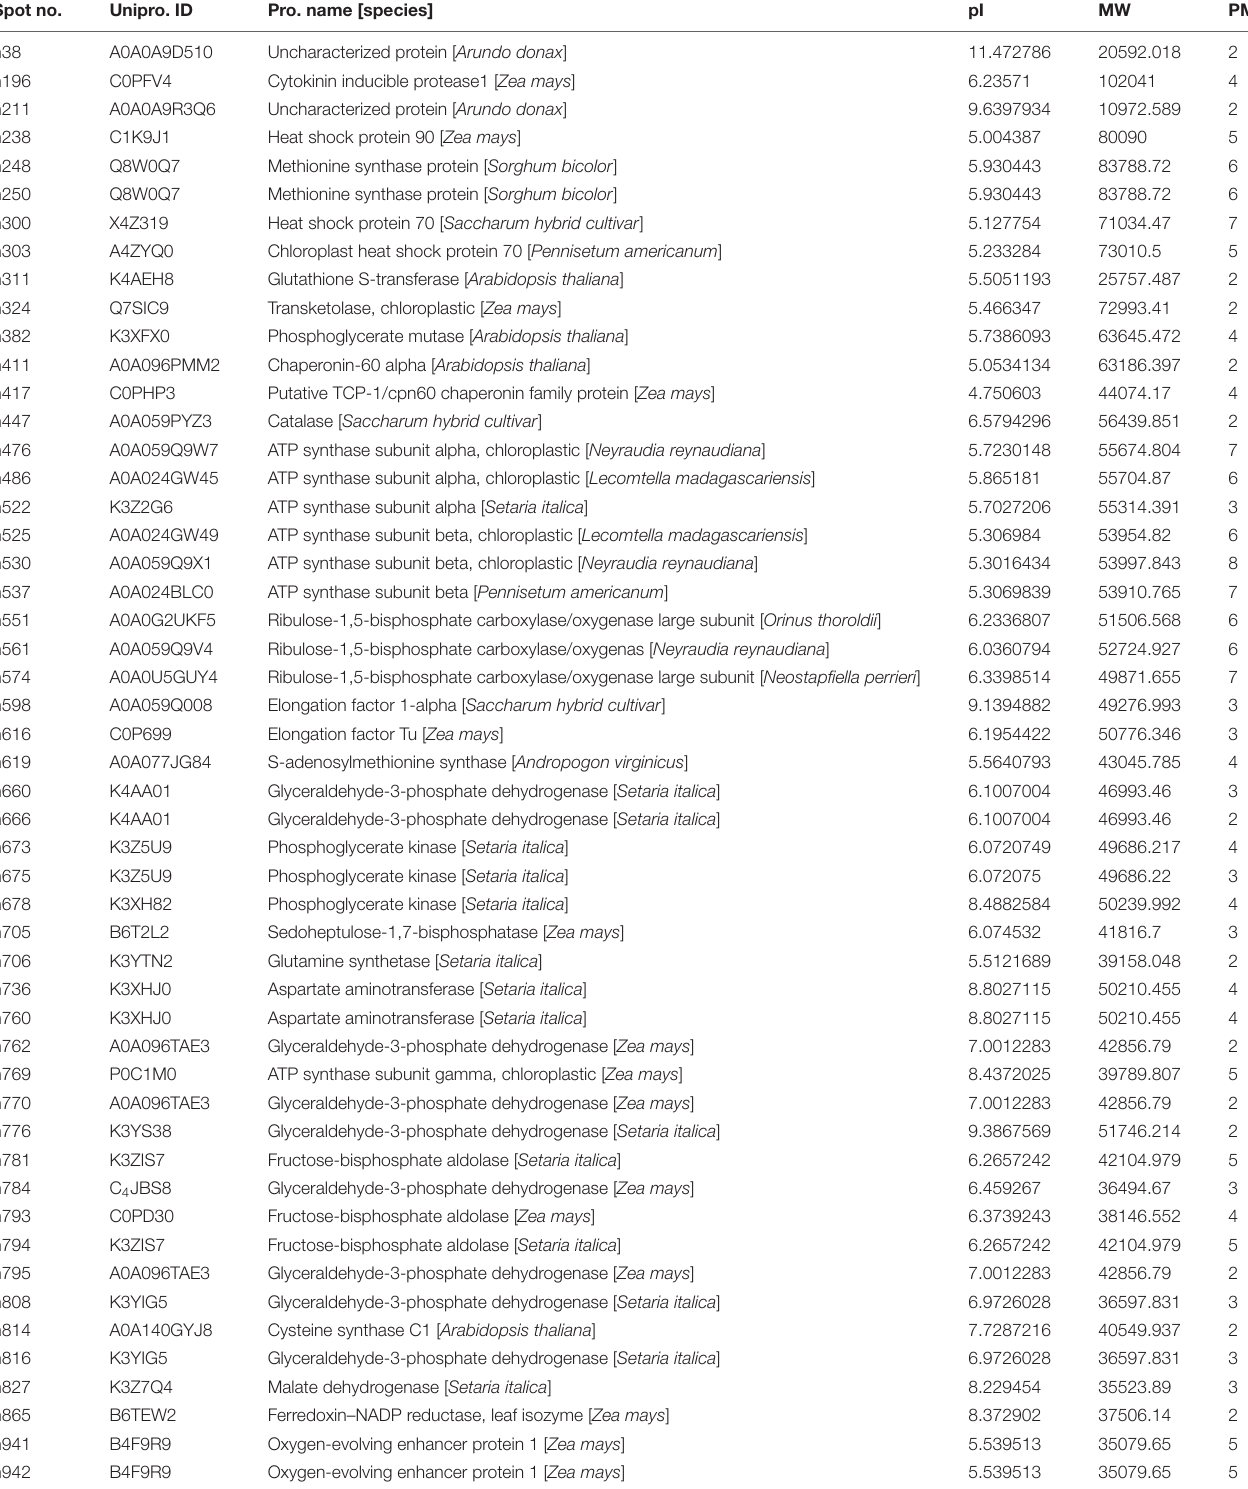
TABLE 2 | Differentially expressed proteins in response to different CO 2 concentrations and temperatures by comparison between elevated CO 2 and ambient CO 2 in leaves of bermudagrass at 28 days of treatments. Spot no. Unipro.